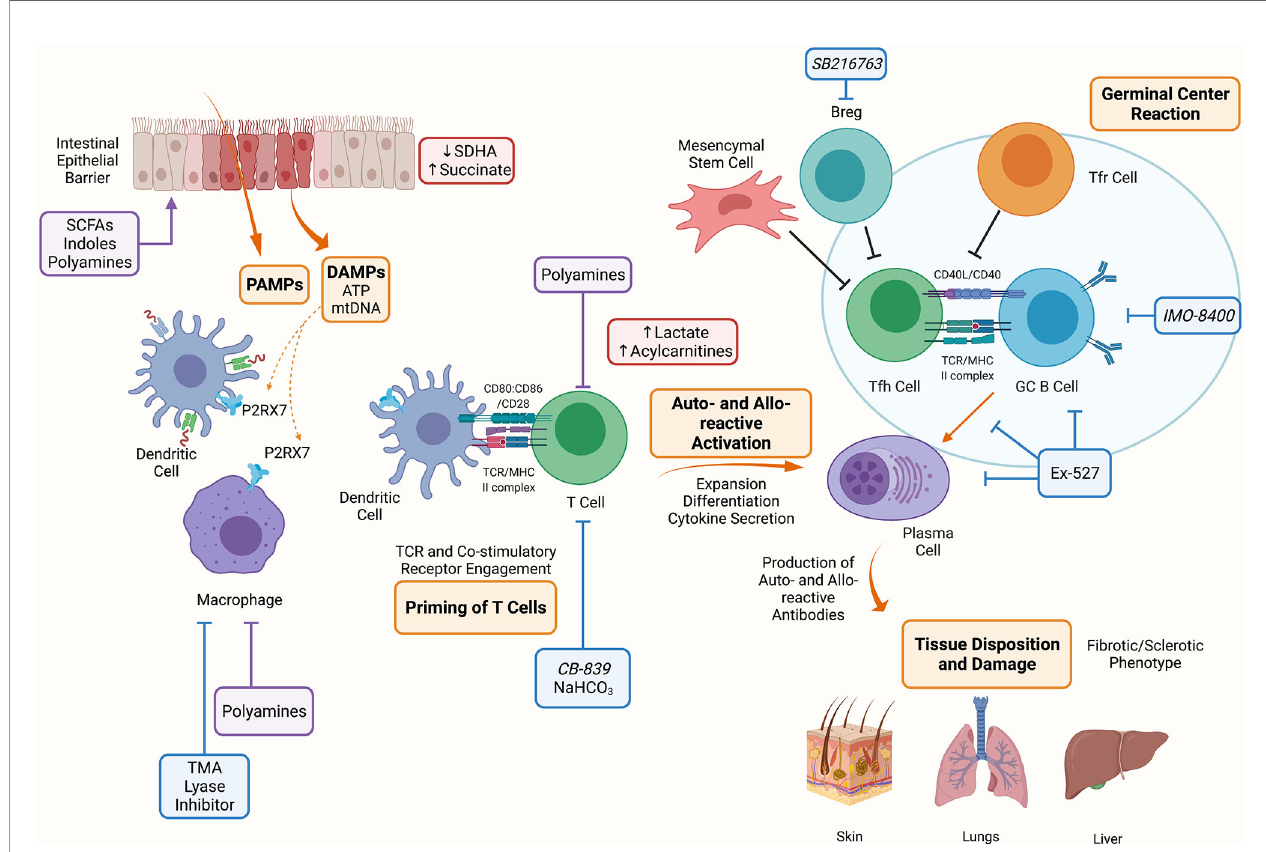
FIGURE 2 | Metabolic Targets of Chronic Graft Versus Host Disease. The conditioning regimen mediates tissue damage releasing PAMPs and DAMPs, these prime APCs to activate T cells. Alloreactive T cells expand and differentiate into Tfh cells which provide costimulatory signals to B cells resulting in the formation of the germinal center and production of auto- and allo-antibodies. These antibodies deposit onto target organs such as skin, lungs and liver mediating the fi brotic and sclerotic phenotype characteristic of cGVHD. Indicated in blue are metabolic targets for the treatment of cGVHD. Trimethylamine (TMA) lyase inhibitor prevents the polarization of macrophages into M1 cells. NaHCO 3 has been shown to abrogate lactate accumulation in allo-reactive T cells. CB-839 is a glutaminase inhibitor that may be effective in cGVHD since GLS de fi cient T cells are unable to establish disease. Ex-527 is an inhibitor against Sirtuin-1 that reduced Tfh cell, B cell and plasma cell differentiation and IMO-8400 is a TLR 7/8/9 inhibitor that may be effective against B cells in cGVHD. Lastly, SBGSK3 b inhibitor (SB216763) has been shown to enhance regulatory B cells (Bregs) differentiation and suppressive function and may be a therapeutic target in cGVHD. Indicated in red are metabolites that have been shown to accumulate during aGVHD, these include succinate in IECs due to reduced SDHA activity, and lactate and acylcarnitines in allo-reactive T cells. Indicated in purple are microbial metabolites that act on or in fl uence the function of cells during cGVHD, these include short chain fatty acids (SCFAs), long chain fatty acids (LCFAs), indoles and polyamines which can act on immune (macrophages, T cells) and non-immune (IECs) cells. Created with